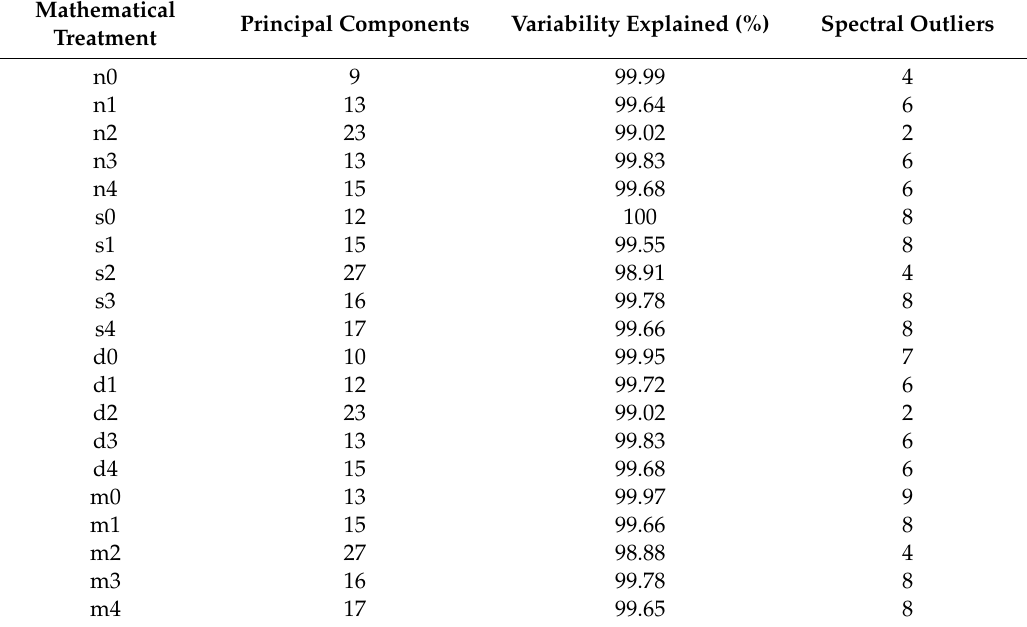
Table 2. Number of principal components, variability explained, and outliers detected for each of the mathematical transformations resulted after principal component analysis on the NIR spectra of the Epichloë -infected meadow fescue samples. The mathematical treatments are indicated as follows: n = no scattering; s = standard normal variate (SNV); d = correction of trend (DT); and m = application of SNV + DT transformations. The smoothing, gaps and derivatives are indicated with a number next to the letter that indicate the scatter treatment: 0 = (0,0,1,1); 1 = (1,4,4,1); 2 = (2,4,4,1), 3 = (2,10,10,1); and, 4 =